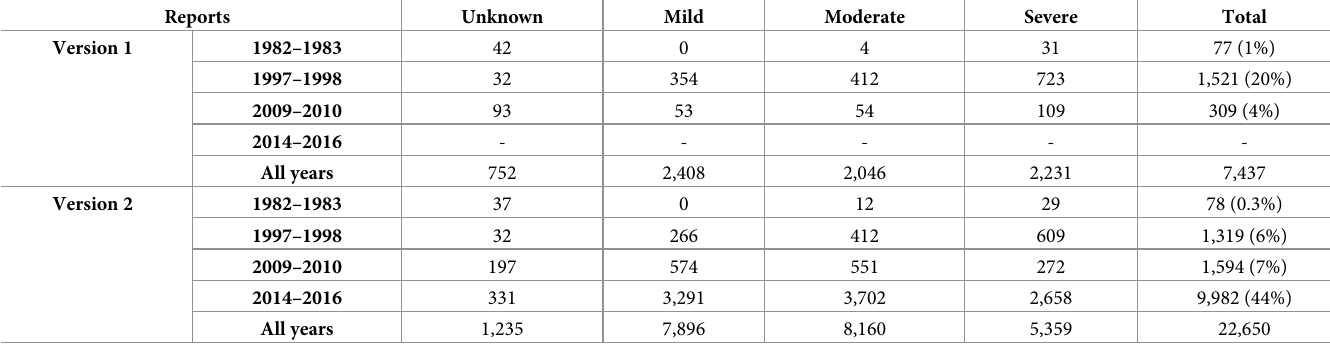
Table 1. Observational bleaching reports for all years and for significant bleaching